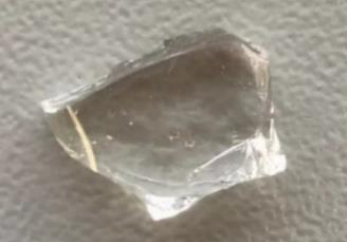
Figure 1. The image of the produced glass.